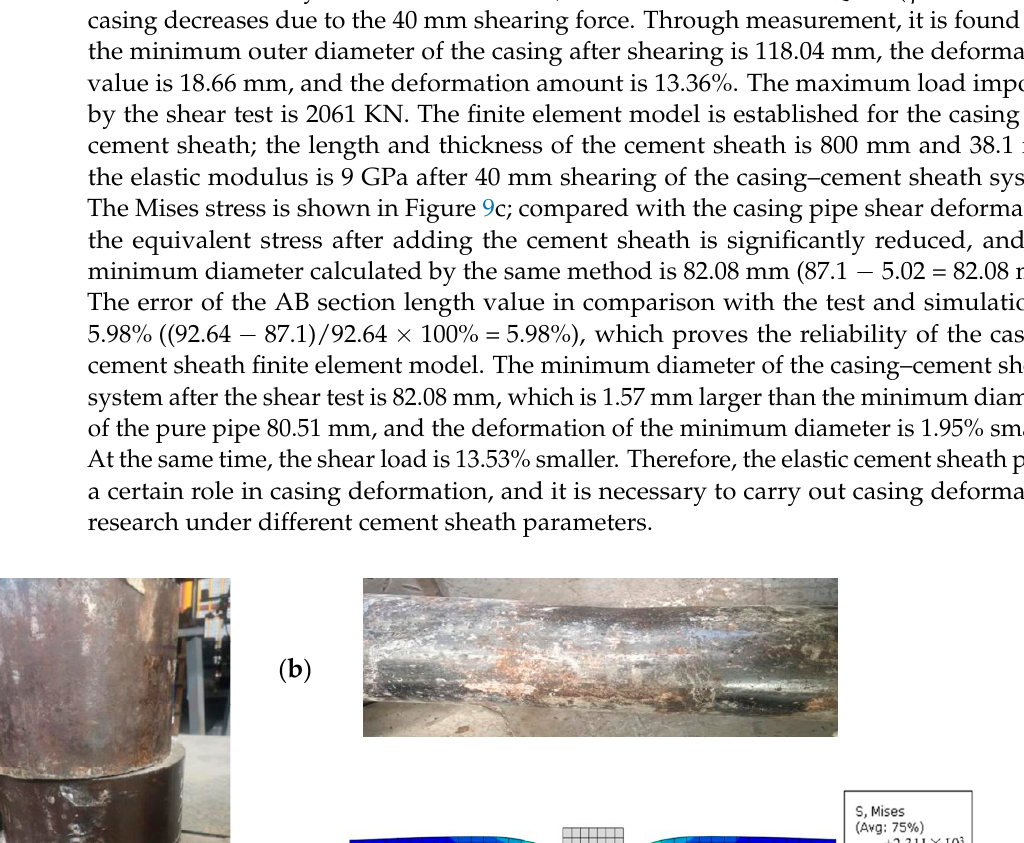
Figure 8. Casing deformation morphology after 40 mm shear deformation: ( a ) test equipment; ( b ) test morphology; ( c ) equivalent stress distribution diagram of finite element simulation.